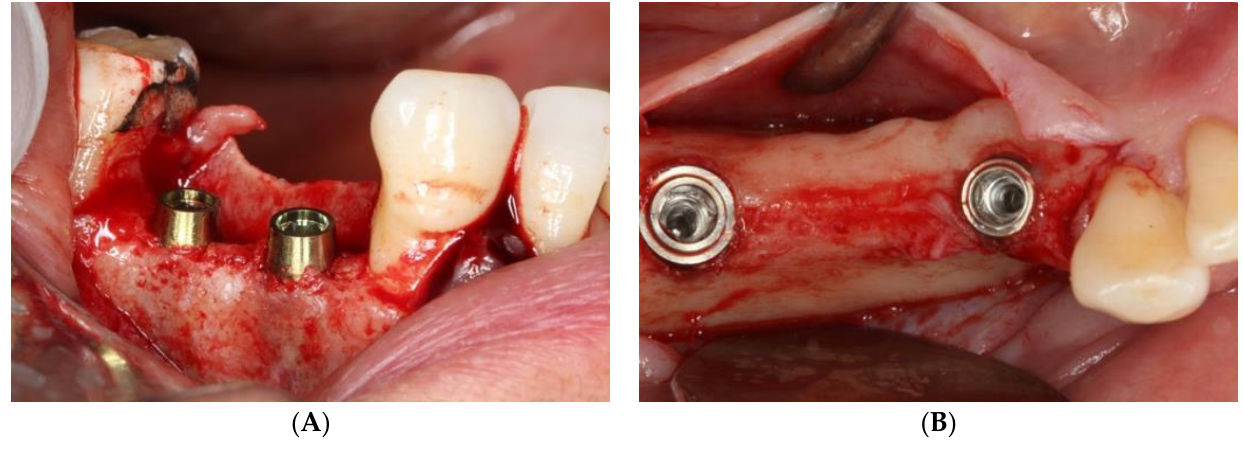
Figure 1. ( A ) tissue level implants, ( B ) bone level